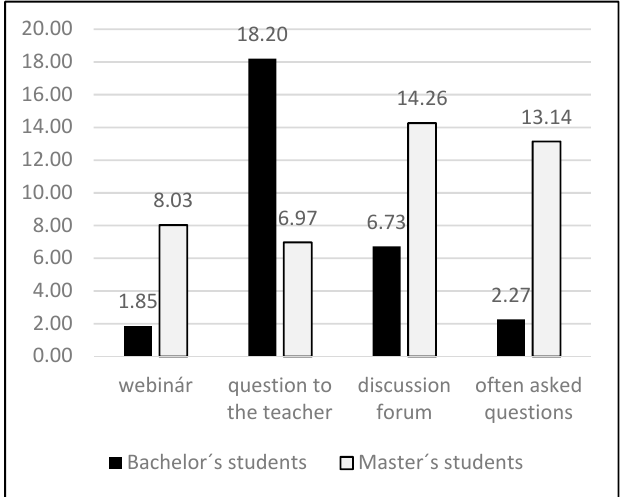
Figure 8. Average visit in options under ‘Social constructivism’.